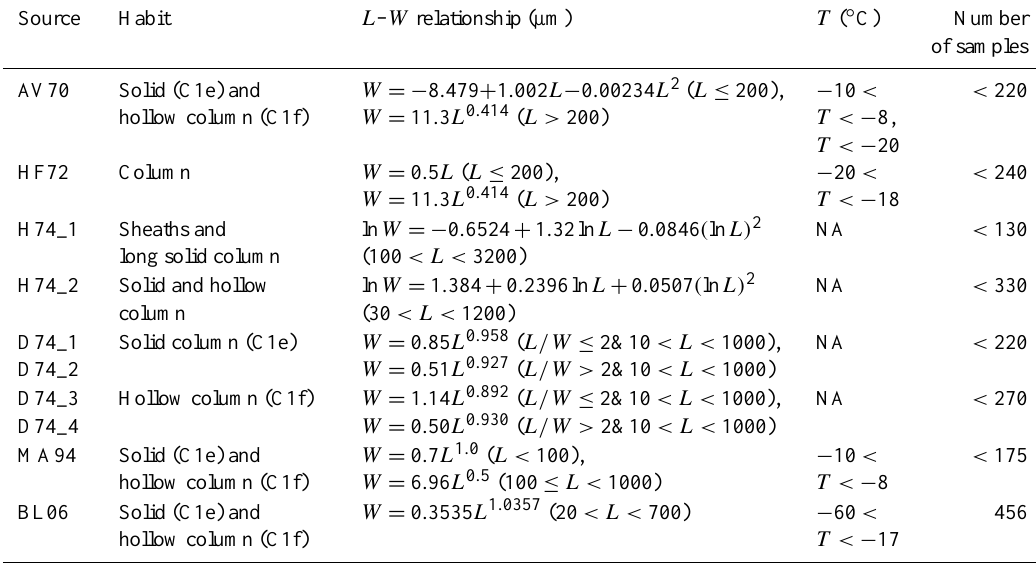
Table 1. Summary of L – W relationships of column crystals from previous studies: AV70 (Auer and Veal, 1970), HF72 (Heymsfield, 1972), H74 (Hobbs et al., 1974), D74 (Davis, 1974), MA94 (Mitchell and Arnott, 1994), and BL06 (Baker and Lawson, 2006). Ice crystal habit classification (Magono and Lee, 1966) is also shown when the original work indicated habit. NA indicates that corresponding information is not available.